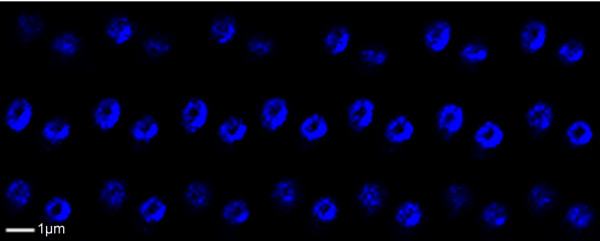
Optical sections of nucleoids in a pair of D. proteolyticus cells. The series is in order from left to right of the images within a row and from top to bottom of the rows within the figure. Images are taken at 100 nm intervals.